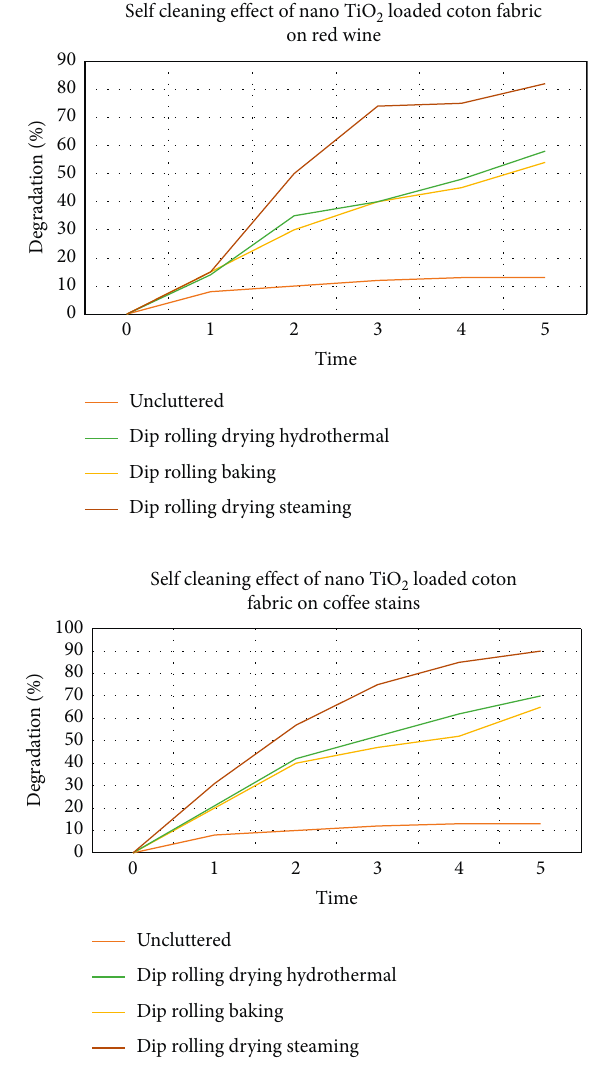
2 -loaded cotton fabric on